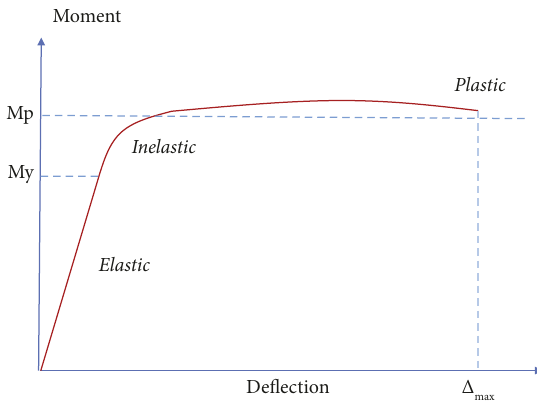
Figure 1: The general behavior of wide-flange